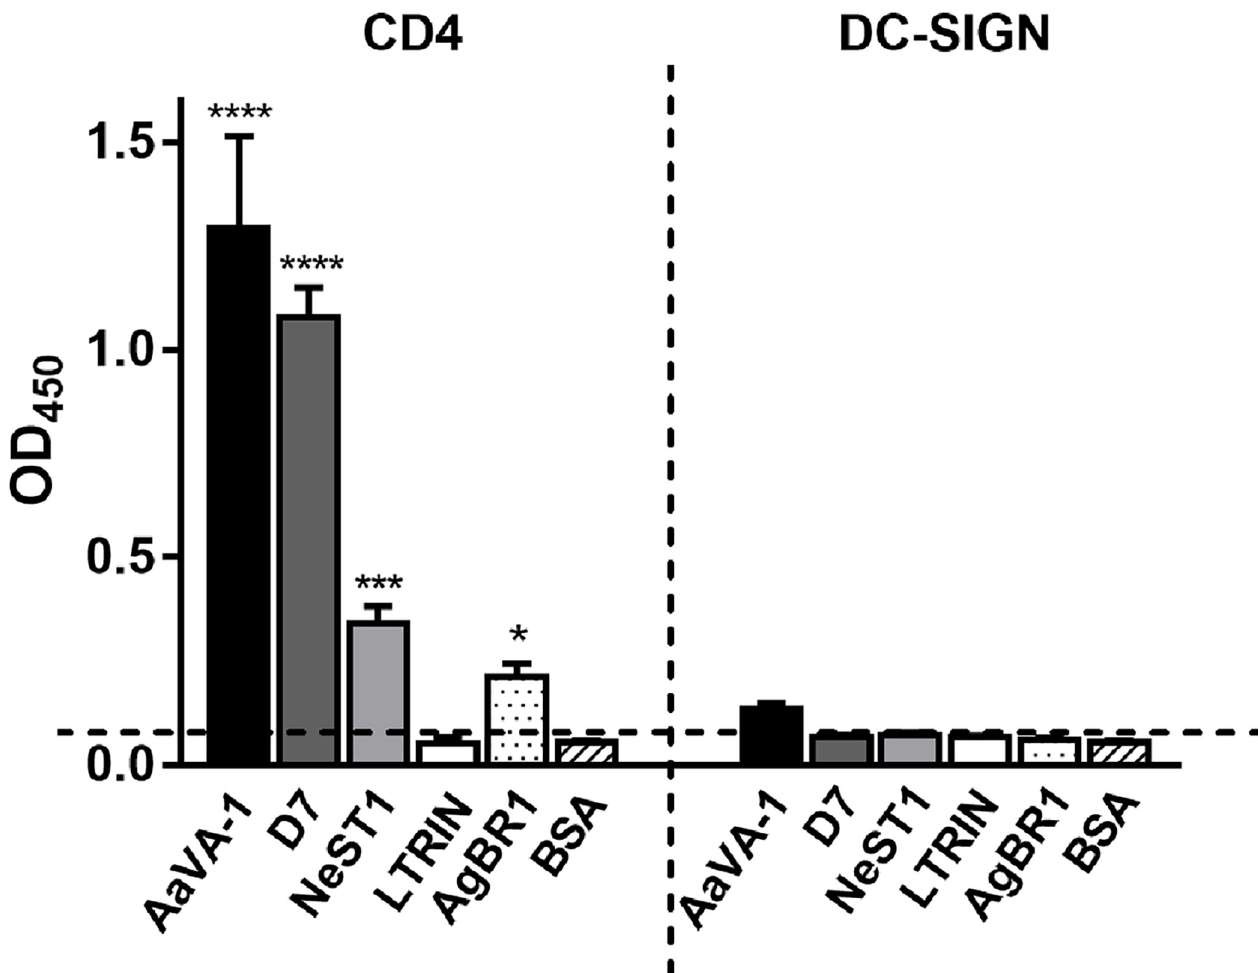
Fig 3. Interaction of recombinant ectodomain CD4 and DC-SIGN proteins with individual recombinant SGPs. ELISA results of SGPs interaction with CD4 protein and DC-SIGN protein. The mosquito SGPs include: AaVA-1, D7 (AAEL006417), Neutrophil stimulating protein 1 (NeST1), Lymphotoxin- β receptor inhibitor (LTRIN), and Ae . aegypti bacteria-responsive protein 1 (AgBR1). Bovine serum albumin (BSA) was used as a negative control. LTRIN and AgBR1 were not previously identified in our pull-down experiment. Statistical significance was calculated using the two-way ANOVA on GraphPad Prism version 7.0 and represented as p values: � p < 0.05, ��� p < 0.001, ���� p < 0.0001. The cut-off value of negative control was calculated as the mean + three times the standard deviation at the value of 0.066 which is shown the dashed line before applying the statistical